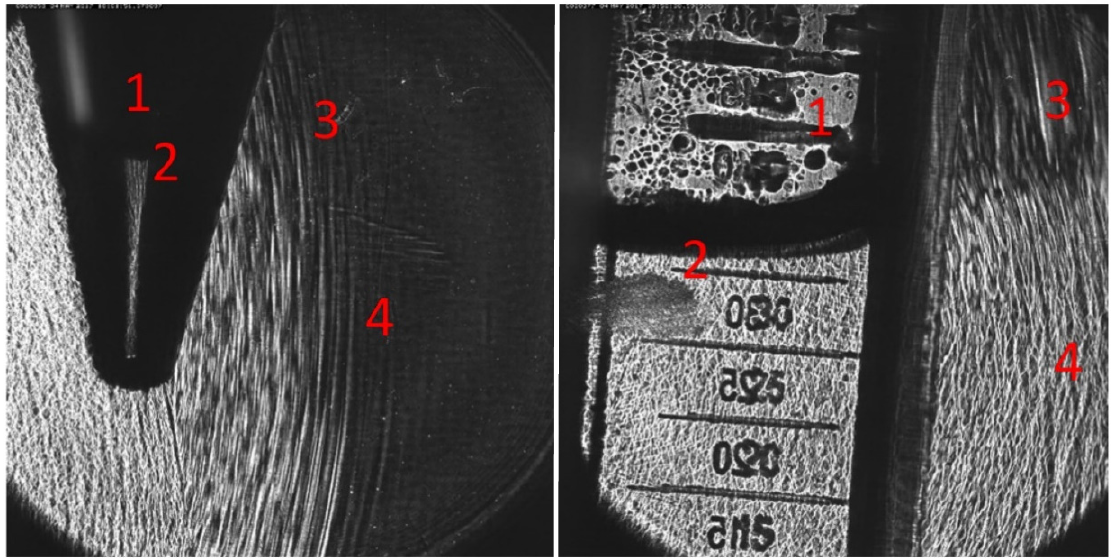
Figure 4. OPCD images of an electrohydraulic generated shockwave front incident on a sample filled 10 mL Falcon tubes ( left ) and a 25 cm 2 cell culture flask ( right ). No wave propagation is observed through air compartments (1) and reflected (2), diffracted (3), and transmitted (4) wave-components are clearly visible about the sample-air interface in the container.